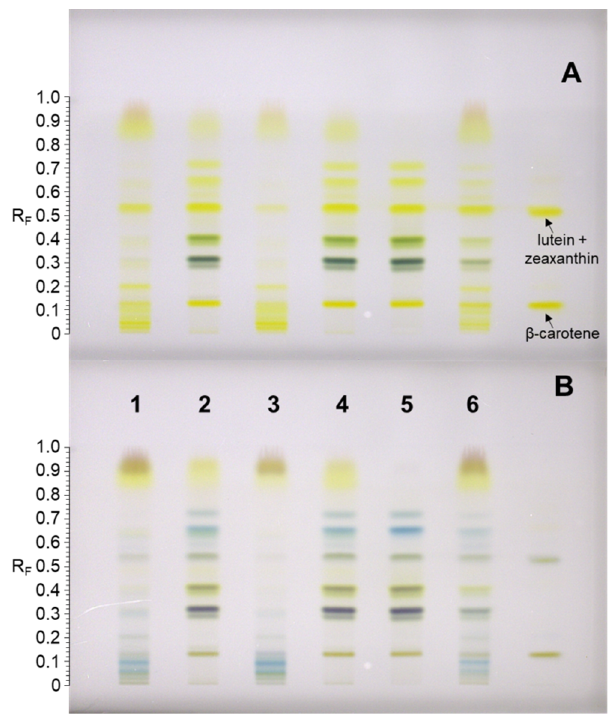
Figure 1. Chromatograms of leaf extracts on C18 HPTLC silica gel plates before ( A ) and after ( B ) exposure to HCl. Plates were developed with acetone:methanol (1:1 v/v ) + 0.1% TBHQ in a saturated twin trough chamber and the images were acquired using white light in transmission mode. Plates were predeveloped with MeOH:dichloromethane 3:1 ( v/v ). Tracks: Yellow leaves of Bohemian knotweed ( 1 ), green leaves of Bohemian knotweed ( 2 ), yellow leaves of Japanese knotweed ( 3 ), green leaves of Japanese knotweed ( 4 ), spinach leaves ( 5 ), green–yellowish leaves of Japanese knotweed ( 6 ), and standard solution mix of (all- trans )-lutein (200 ng), (all- trans )-zeaxanthin (200 ng), and (all- trans )-β-carotene (500 ng) ( 7 ).